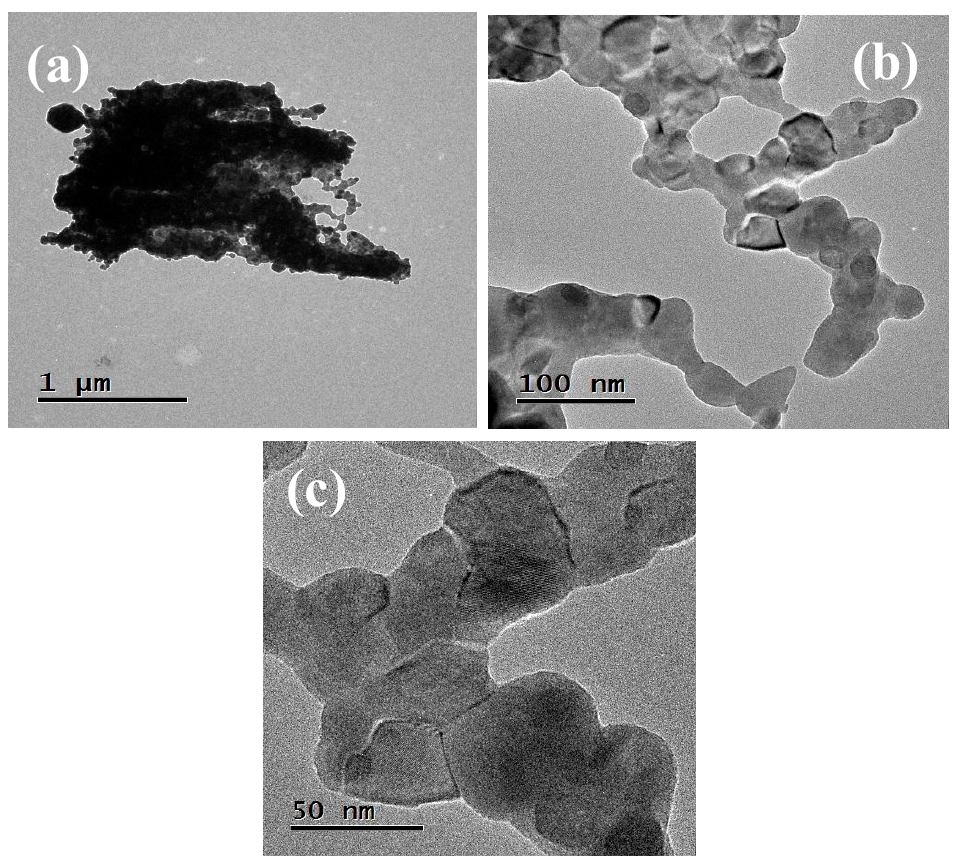
Figure 5. ( a – c ) TEM photomicrographs of the manganese antimonate nanoparticles calcined at 800 ◦ C.